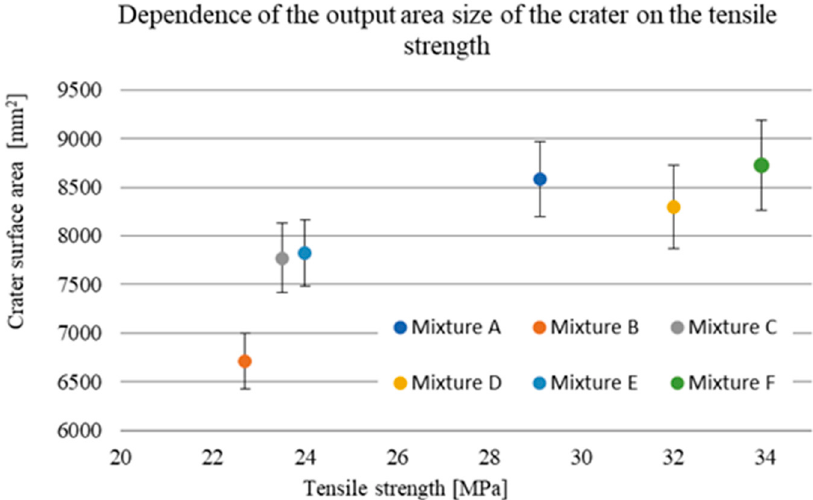
Figure 13. Outlet crater surface size versus compressive strength.